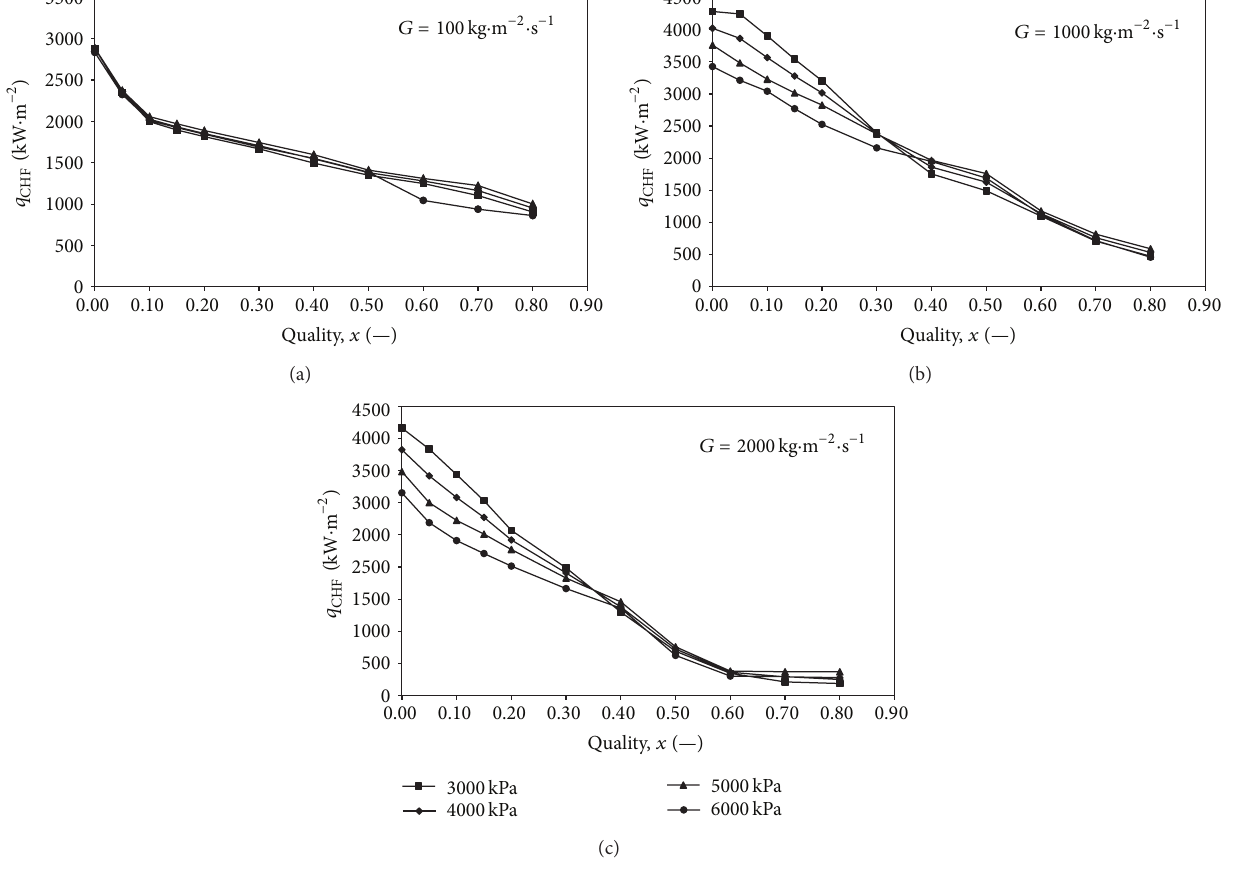
Figure 1: Effect of pressure on CHF for vertical up-flow of water in 67mm diameter tube as predicted by CHF-LUT. Table 2: Effect of high heat flux and tube blockage on CHF occurrence for a 67mm vertical boiler